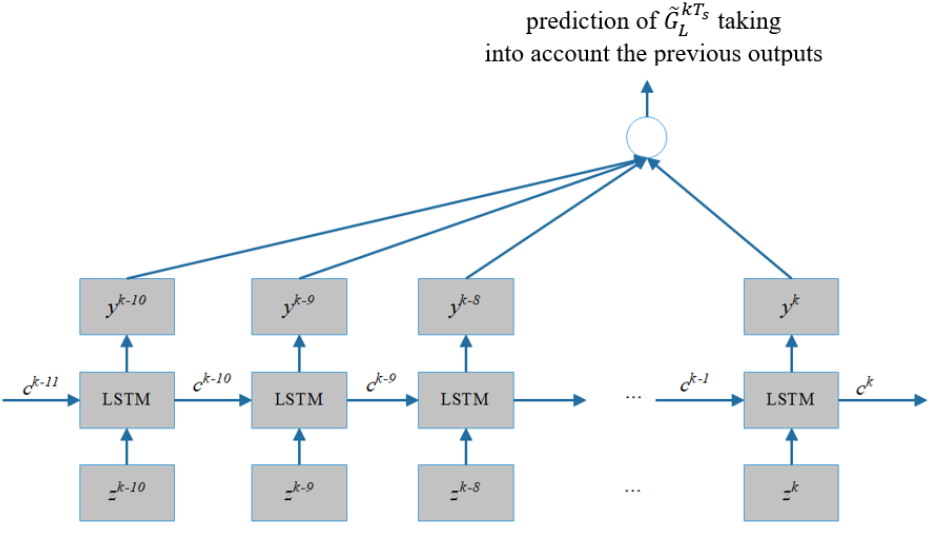
Figure 11. Unrolled LSTM